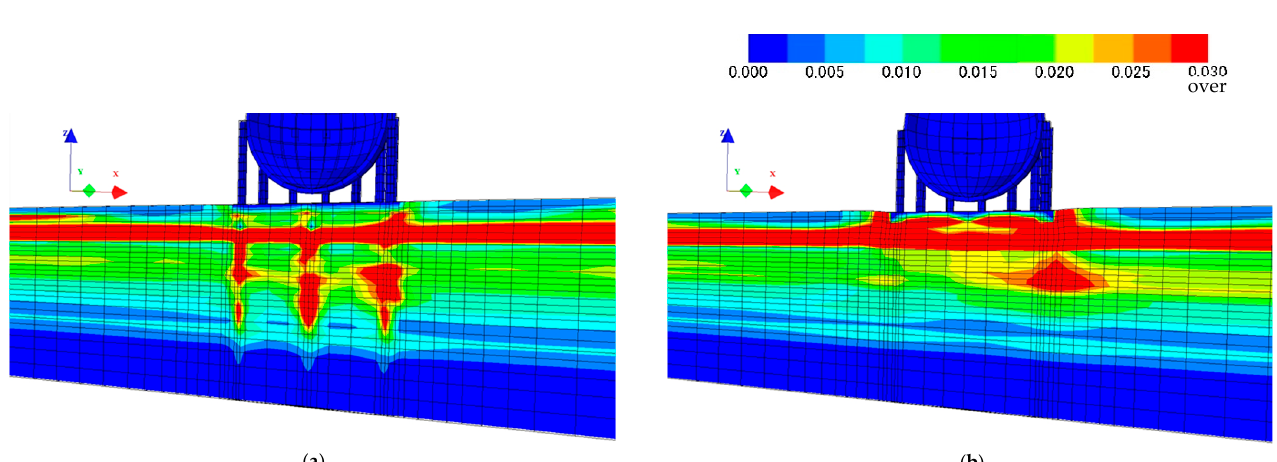
Figure 20. Shear strain distribution (maximum value until the end of an earthquake) of ( a ) with-piles and ( b ) without-piles models during seismic motion (A).